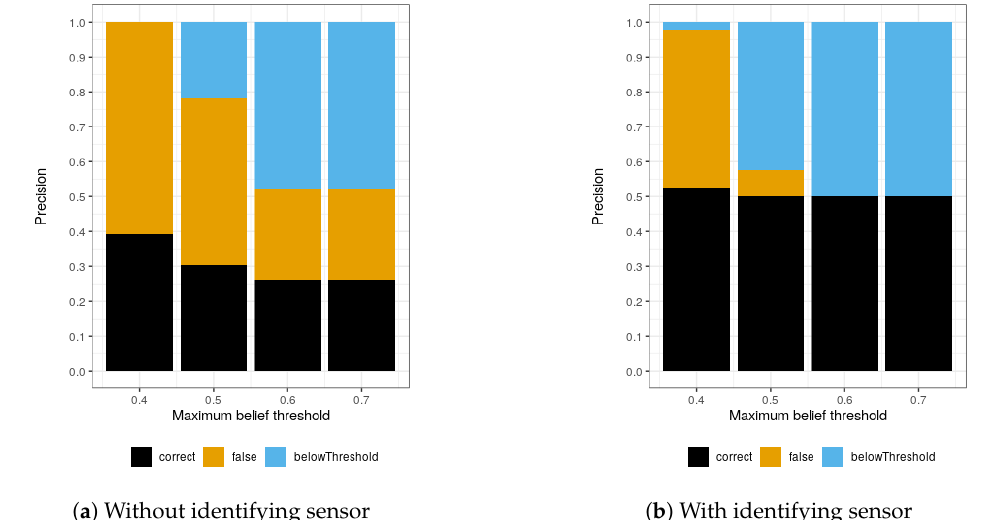
Figure 6. Results of track clustering on field trial data with Constrained Evidential C-Means and filtering over cluster membership grades (C-Means) and normalized beliefs